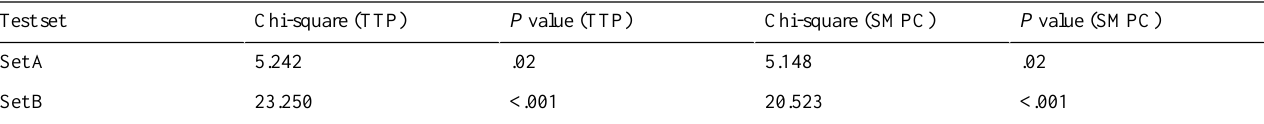
Table 2. Comparison of the results obtained by insecure computation on a trusted third party (TTP) and by secure multiparty computation